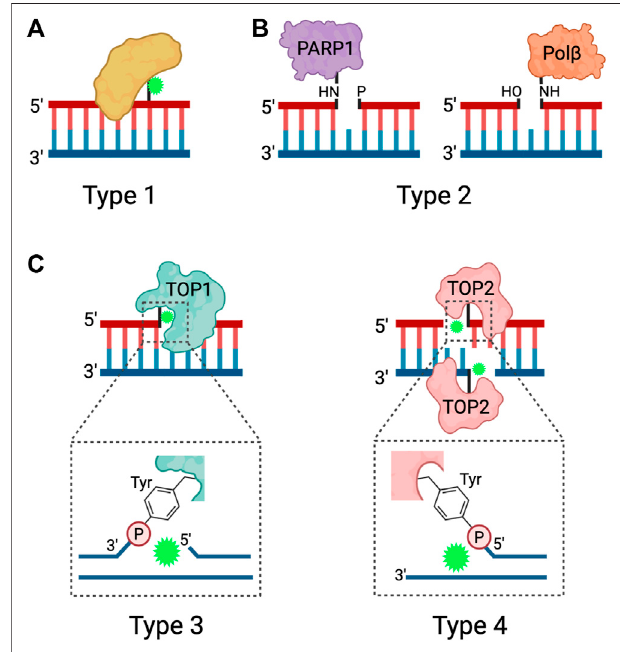
FIGURE1| TypesofDPCs.SchematicdepictingthefourtypesofDPCs. (A) Type 1 DPCs are proteins crosslinked to unperturbed duplex DNA, generally induced by nonspeci fi c agents. (B) Type 2 DPCs are crosslinked to the ends of SSBs and arise from abortive DNA repair processes. (C) Types 3 and 4 DPCs are abortive DNA-topoisomerase DPCs, where TOP1 is crosslinked to the 3 ʹ end of a SSB or TOP2 is crosslinked to the 5 ʹ ends of a DSB via a phosphotyrosyl bond. Adapted from Nakano et al. (2017), Stingele et al. (2017). Created in